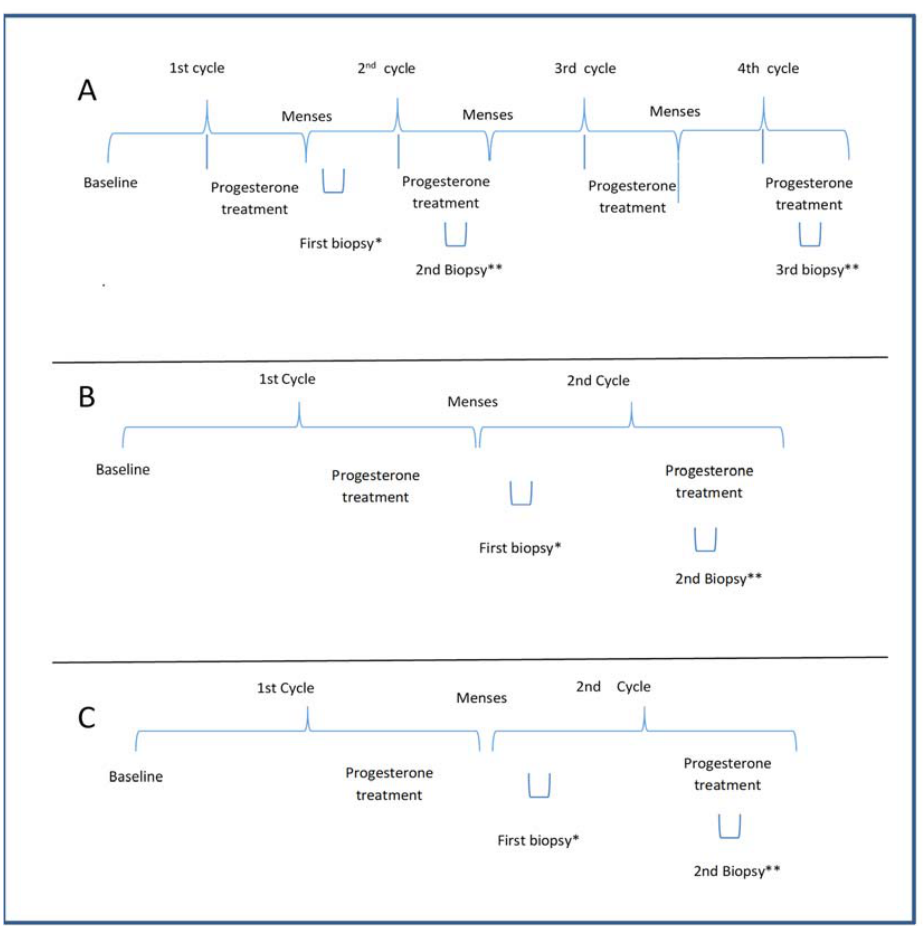
Figure 2. ( A ) The protocol for evaluating the effect of the number of cycles of progesterone on the endometrium in PCOS in Study A. The second and third biopsies were performed under progesterone treatment in the pilot study; ( B ) The protocol of treatment and biopsy for PCOS in Study B; ( C ) The protocol of treatment and biopsy for the control group in Study C. Baseline of A and B: Patients having amenorrhea with negative beta HCG; Baseline of C: patients with regular menses without any PCOS features; a progesterone treatment period with 400 mg micronized progesterone through the vaginal route; * the first biopsy was performed during the 5th to 9th day of the menstrual cycle; ** the biopsy was done during the progesterone treatment during the 20th to 24th day of the menstrual cycle.